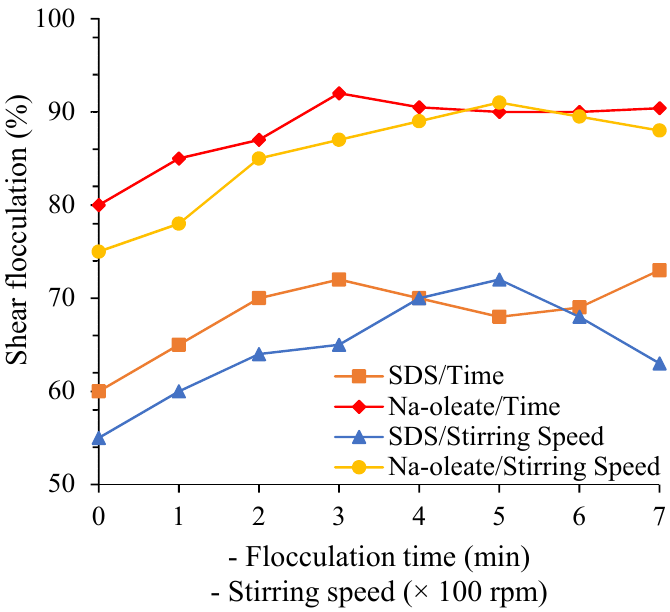
Figure 7. Effect of flocculation time and stirring speed on the degree of shear flocculation [54]. Multivalent ions have been studied for their effects on colemanite shear flocculation (Figure 8). Multivalent ions such as Mg 2+ , Ba 2+ , and Fe 3+ enhance BMs’ flocculation as a function of pH [13]. They reduce the BMs’ negative surface charge and enhance their coagulation in the suspension [39,58,59]. Celik et al. [11] indicated that barium ion is more effective in colemanite flocculation than magnesium ion. The difference in their product solubility with SDS was suggested as the main reason [11]. However, significant decreases in colemanite flocculation were observed at concentrations higher than these ranges [13]. reached at pH between 9–11.5 [11,13].